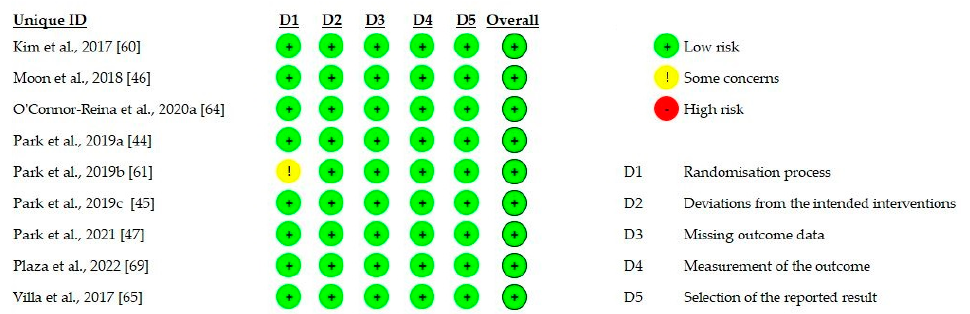
Figure 3. Risk of bias assessment of randomized studies using RoB 2 tool.